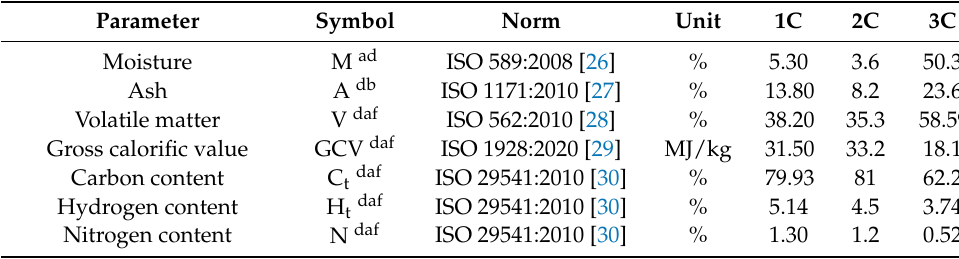
Table 1. Results of proximate and ultimate analyses of coal